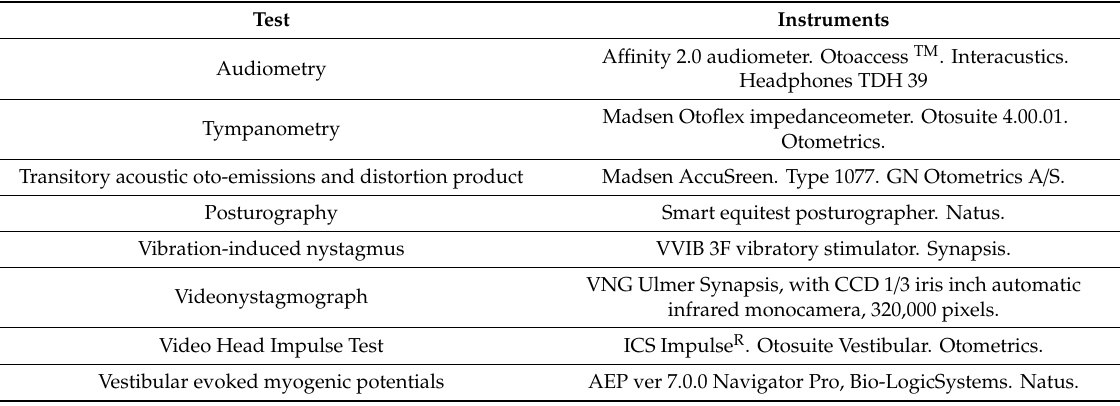
Table 5. Instruments employed to perform the physiological